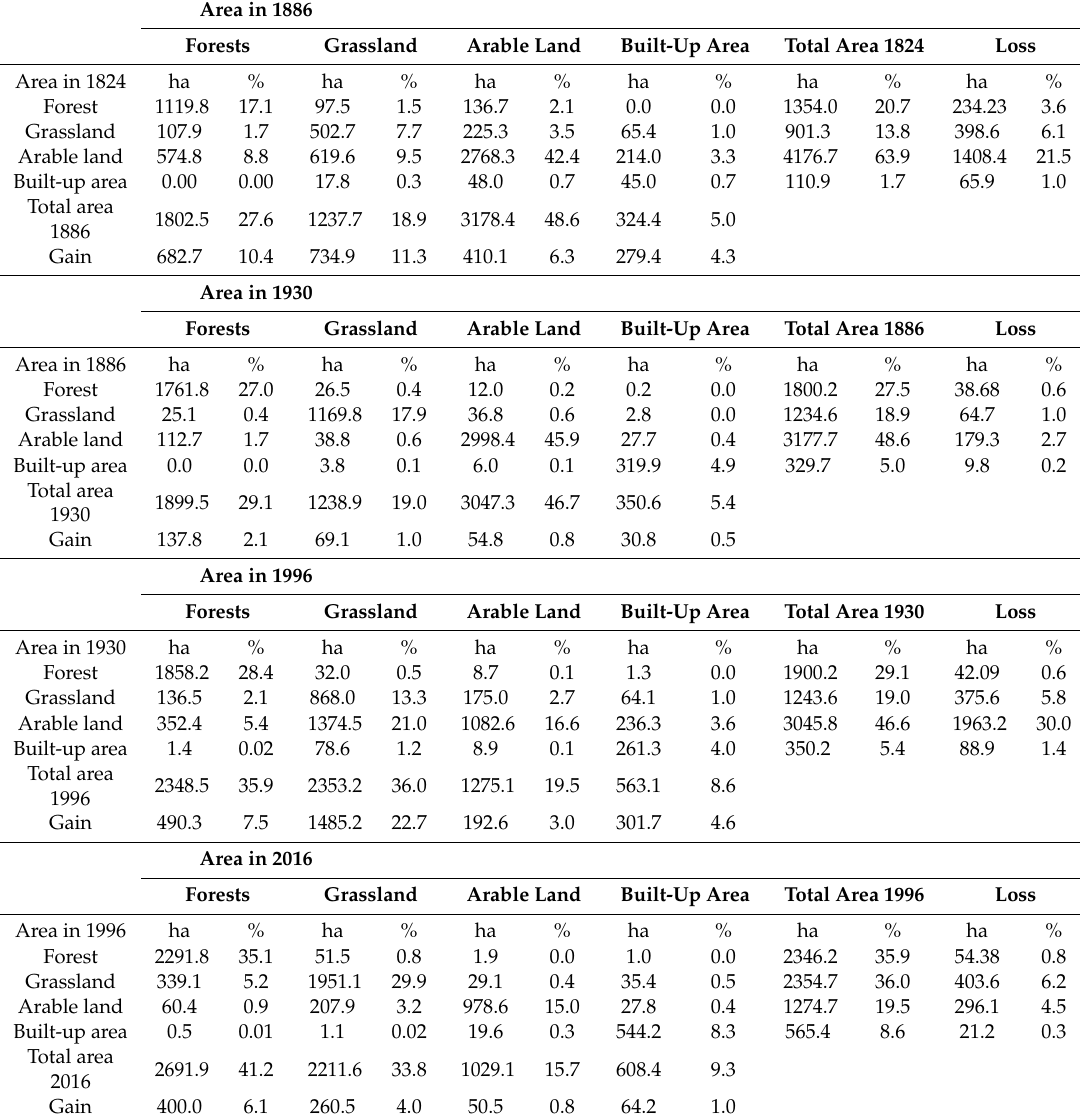
Table 5. Land cover transition matrices